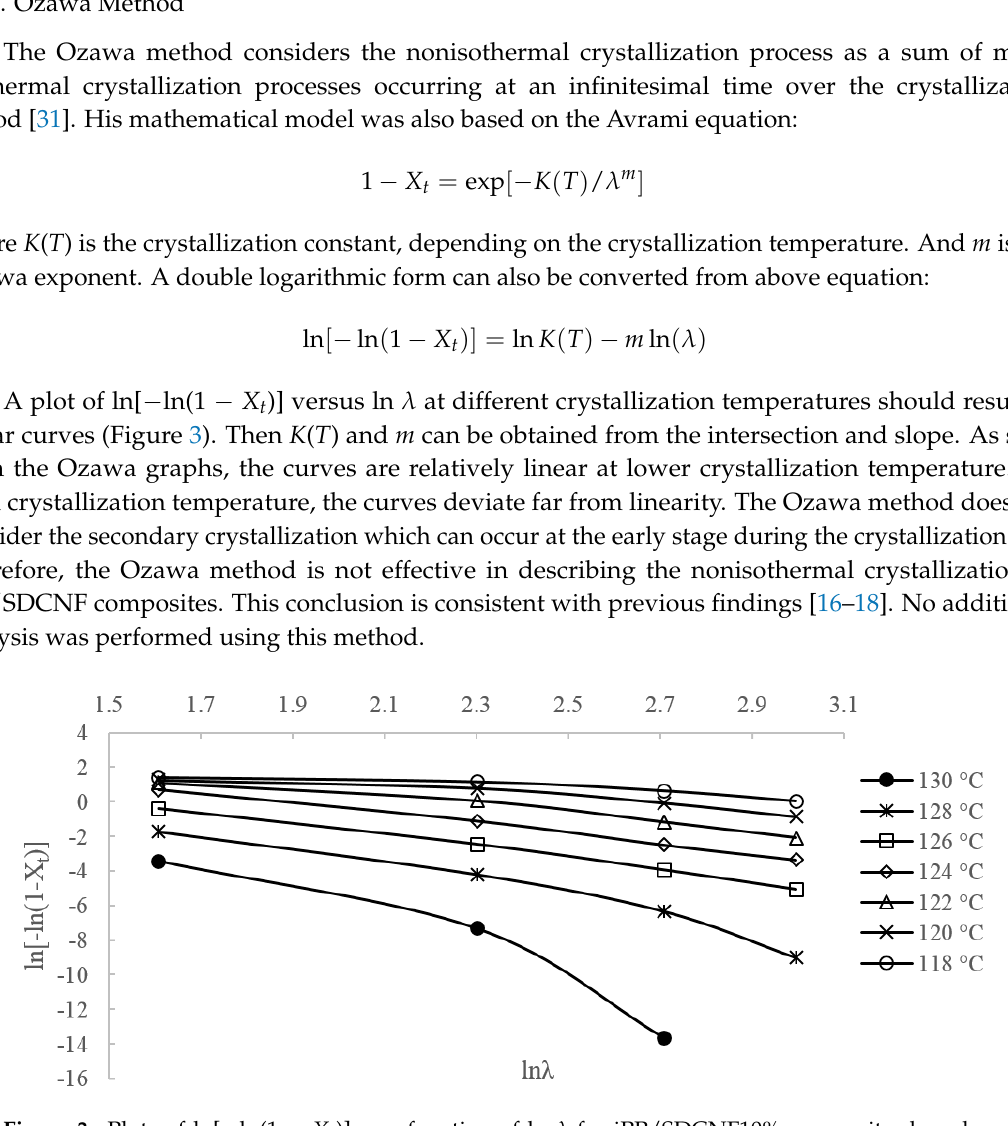
Figure 3. Plots of ln[ − ln(1 − X t )] as a function of ln λ for iPP/SDCNF10% composites based on Ozawa method.